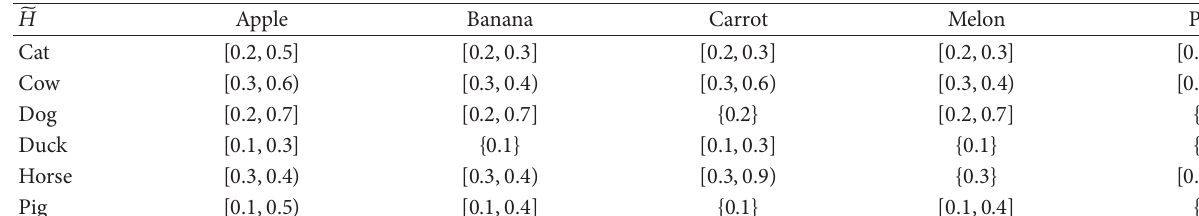
Table 5: Tabular representation of the hesitant fuzzy soft set